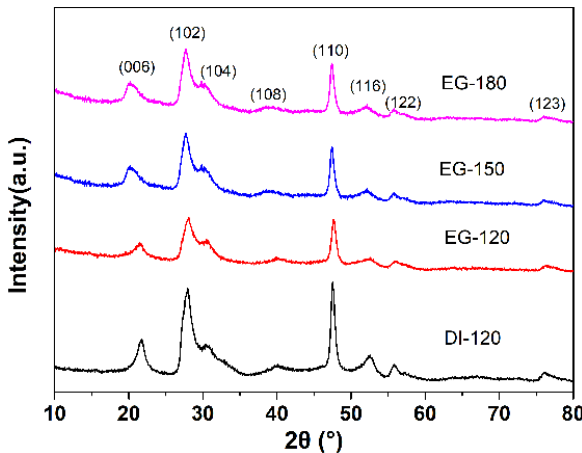
Figure 1. XRD patterns of different ZnIn 2 S 4 photocatalysts.